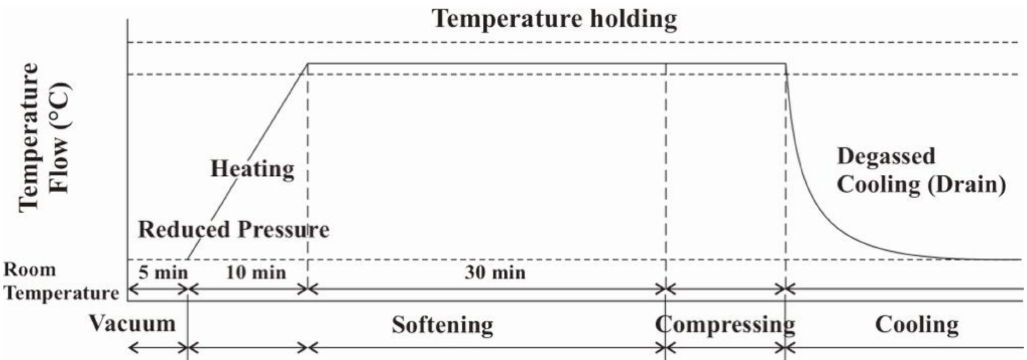
Figure 2. Consolidation process on high-temperature and -pressure